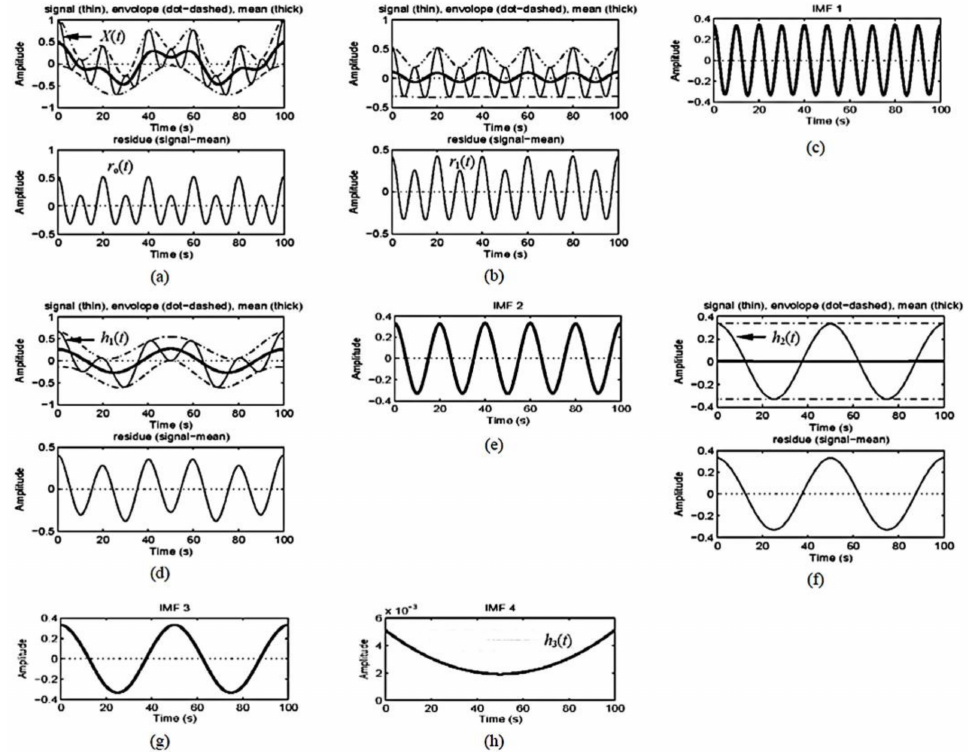
Figure 5. Intrinsic mode function (IMF) shifting process of Hilbert–Huang transform (HHT) [29]. The algorithm utilizes an iterative sifting process that successively subtracts the local mean from a signal. ( a ) The sifting process follows these steps: (1) determine the local extrema (maxima, minima) of the signal; (2) connect the maxima with an interpolation function, creating an upper envelope about the signal; (3) connect the minima with an interpolation function, creating a lower envelope about the signal; (4) calculate the local mean as half of the difference between the upper and lower envelopes; (5) subtract the local mean from the signal. ( b – h ) Iteration on the residual until the trend is obtained